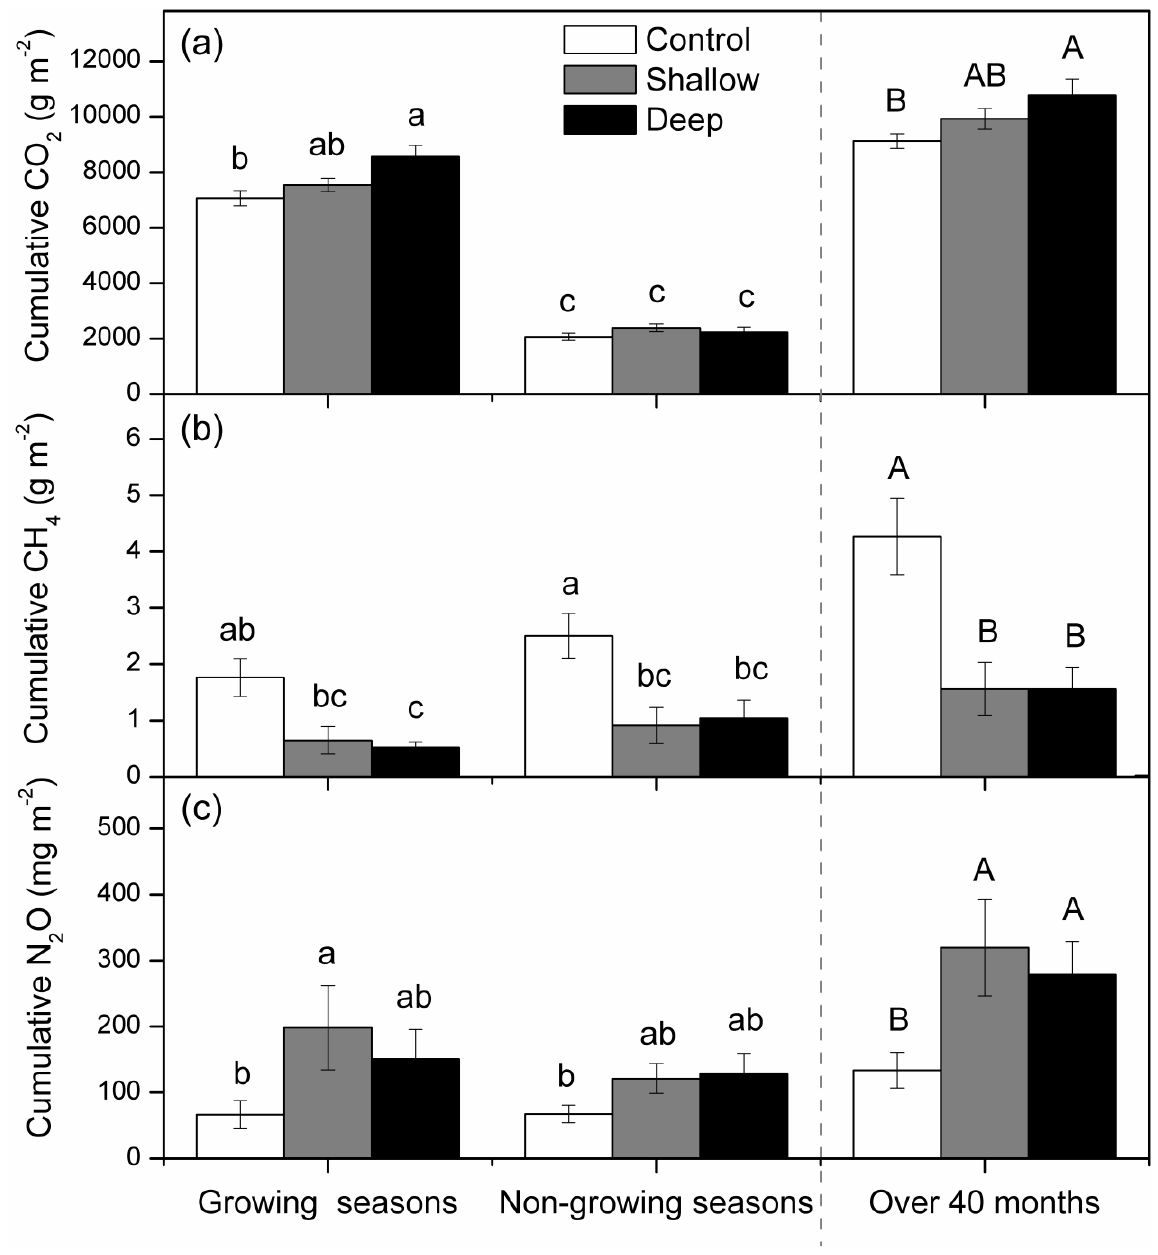
Figure 5. Cumulative emissions of (a) carbon dioxide (CO during the growing seasons, the non-growing seasons and over 40 months, for the control, shallow and deep water table treatments. Different letters indicate a significant difference among the control, shallow and deep water table treatments ( P < 0.05). Error bars represent ±1 Standard